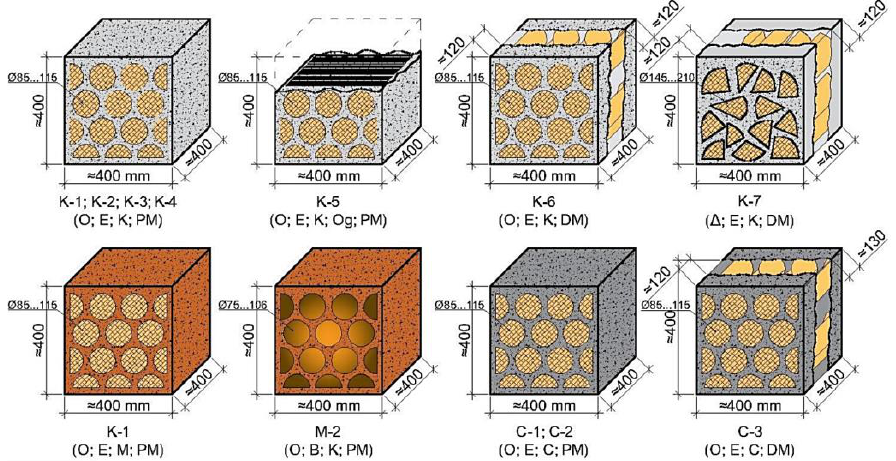
Figure 5. Designations of laboratory